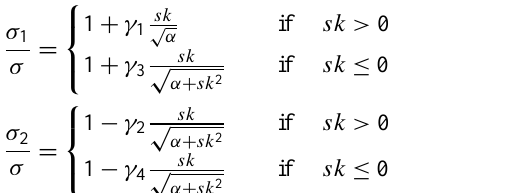
available case studies. The grey shading in (c) corresponds to two times the standard deviation from the four